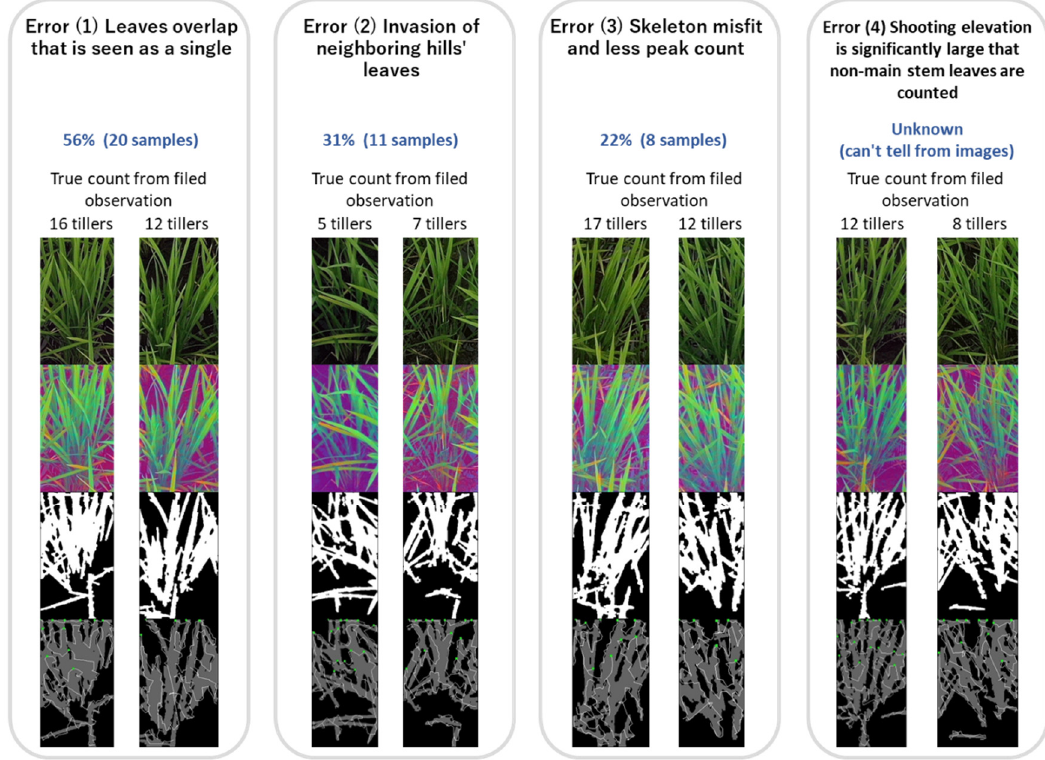
Figure 11. Error type in automatic tiller counting. Undercounting due to leaf-region overlap, over- counting due to invasion of neighboring hills’ leaves, undercounting due to skeleton misfit, and overcounting due to large shooting elevation angles, which counts non-main stem leaves (error larger than four, August 7 observation). In bottom image, white lines represent skeleton of leaves, and green dots represent points which is regarded as leaf tips above center of gravity line.